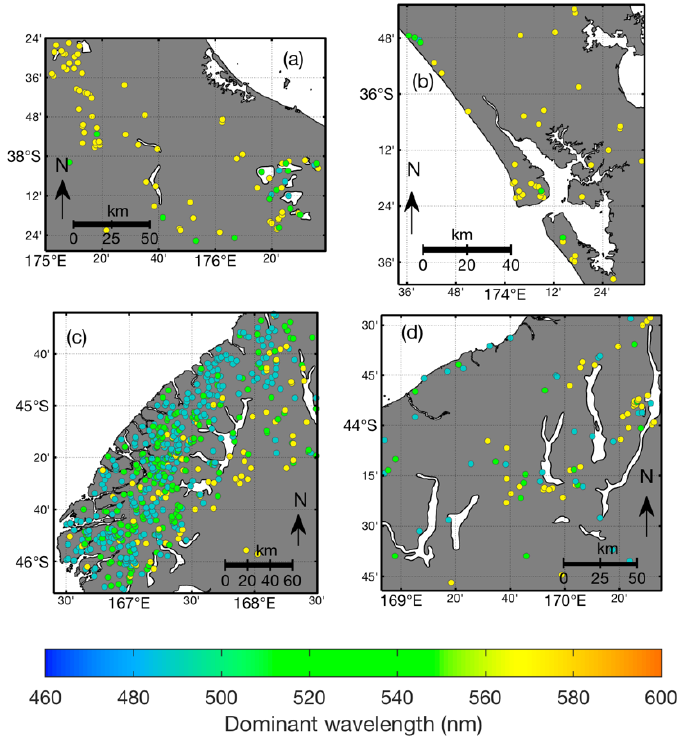
Figure 9. Geographic distribution of lakes coloured by mean dominant wavelength in four areas. Placement of the areas shown in maps ( a – d ) are shown in Figure 5.